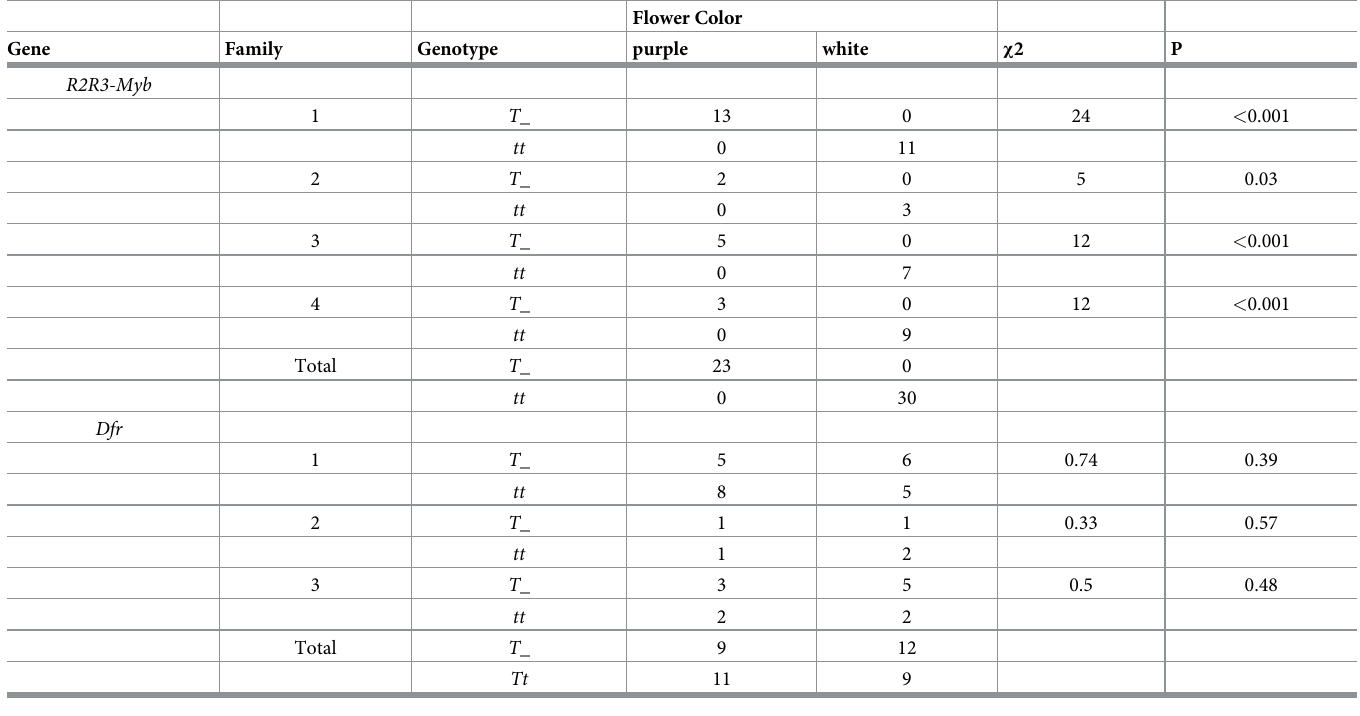
Table 3. Co-segregation analysis of R2R3-Myb ( IlacMyb1 and IleuMyb1 )and Dfr ( IlacDfr and IleuDfr ) with flower color.